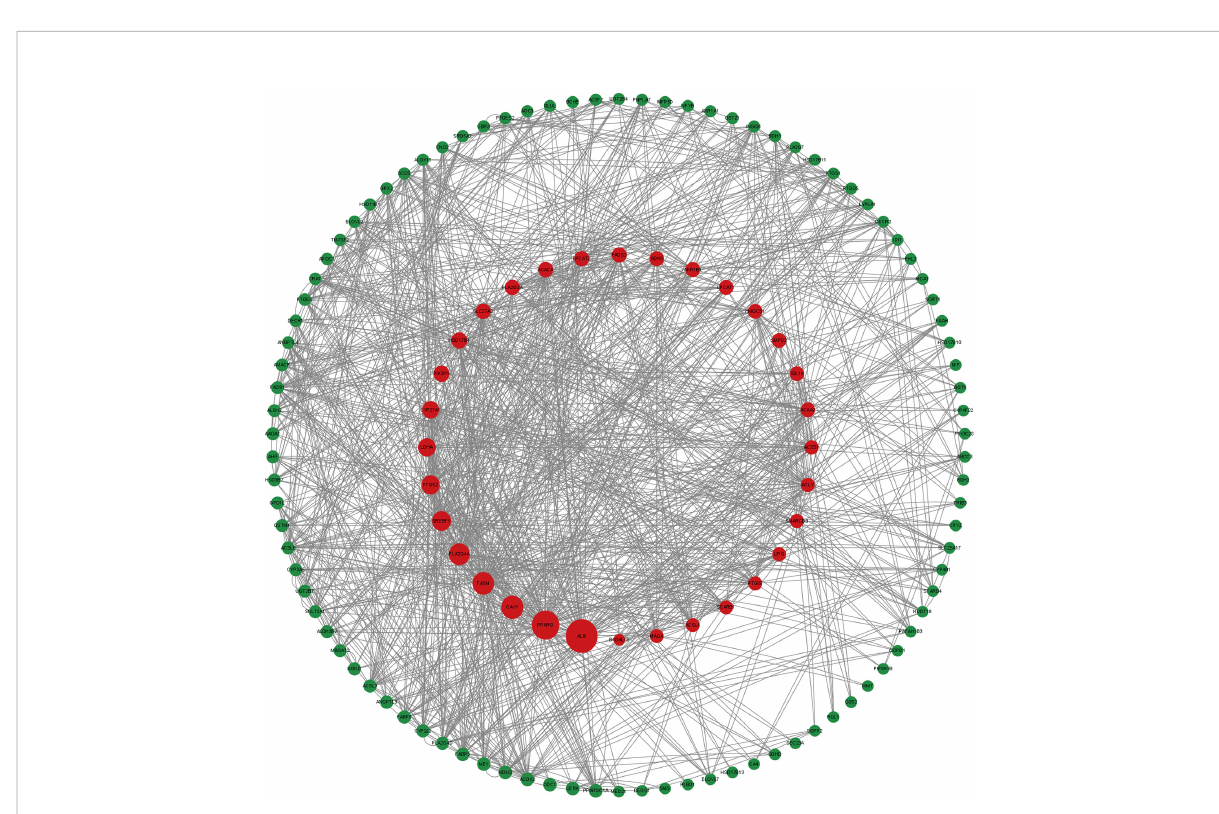
FIGURE 2 Differential gene Protein-protein interaction (PPI)